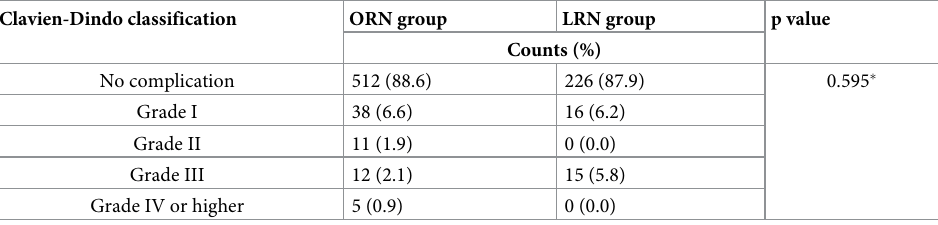
Table 4. Differences between postoperative complications according to surgical approach in the patients with large renal cell carcinoma ( (cid:21) 7 cm) treated with radical nephrectomy. Clavien-Dindo